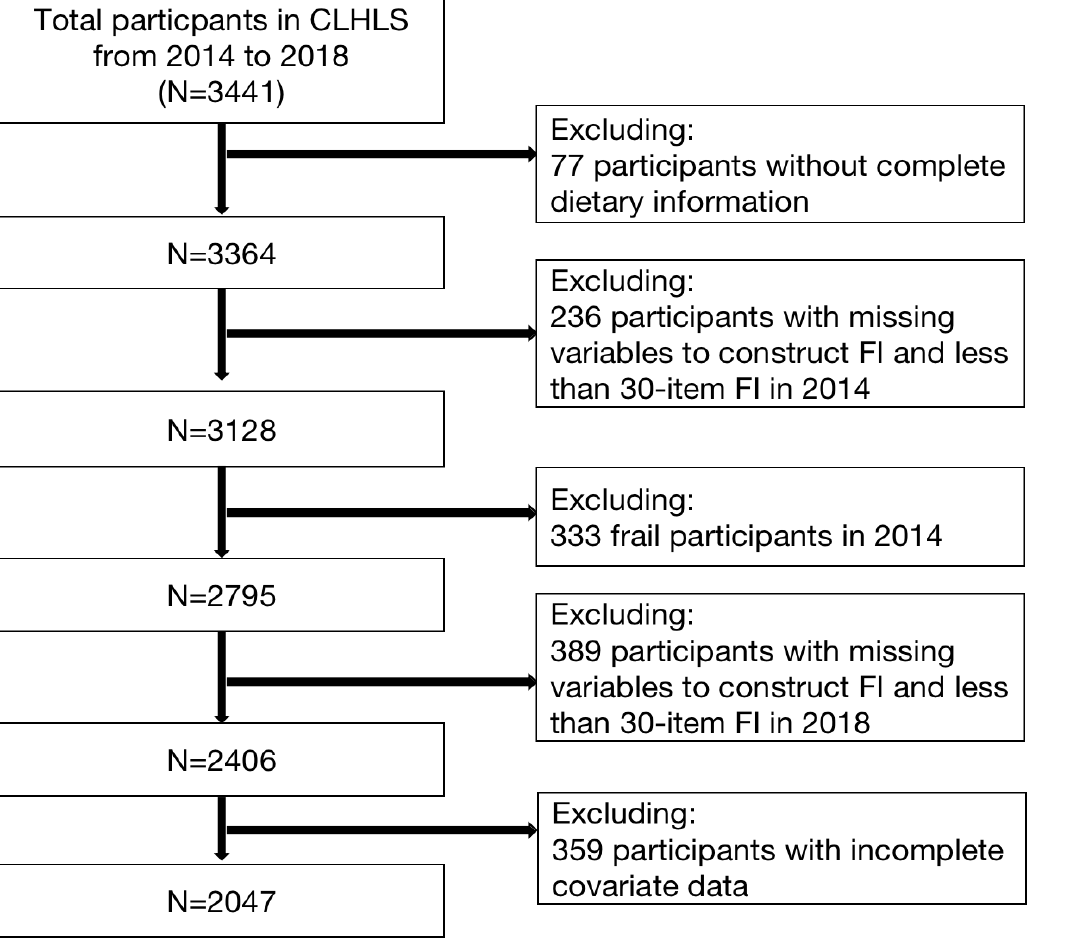
Figure 1. Flowchart showing the selection of the participants enrolled in the CLHLS.